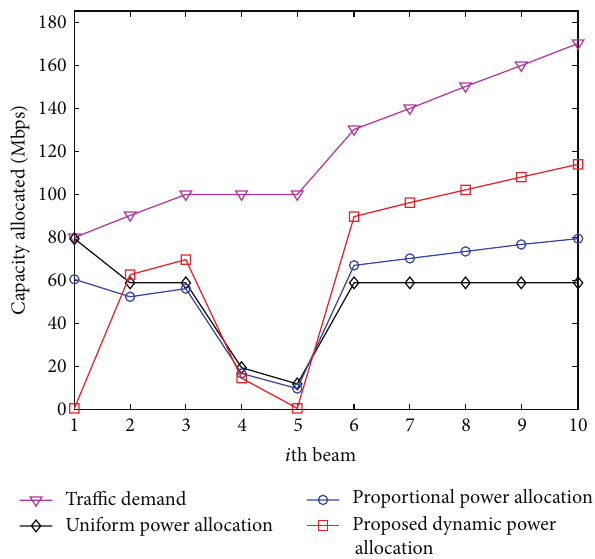
Figure 6: Distribution of the capacity allocated to each beam, for the three algorithms in Scenario 3.